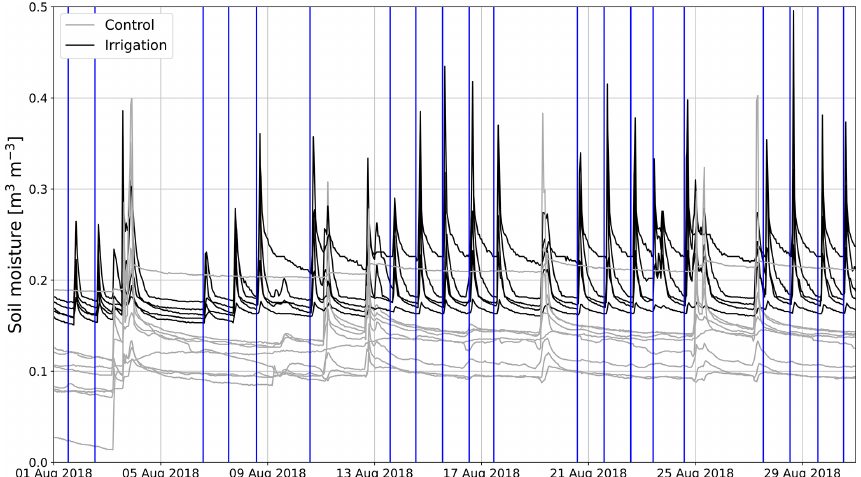
Figure 4. Hourly mean soil moisture time series measured at control (gray) and irrigation (black) plots in August 2018. Vertical blue lines show the times when the irrigation plot was irrigated.